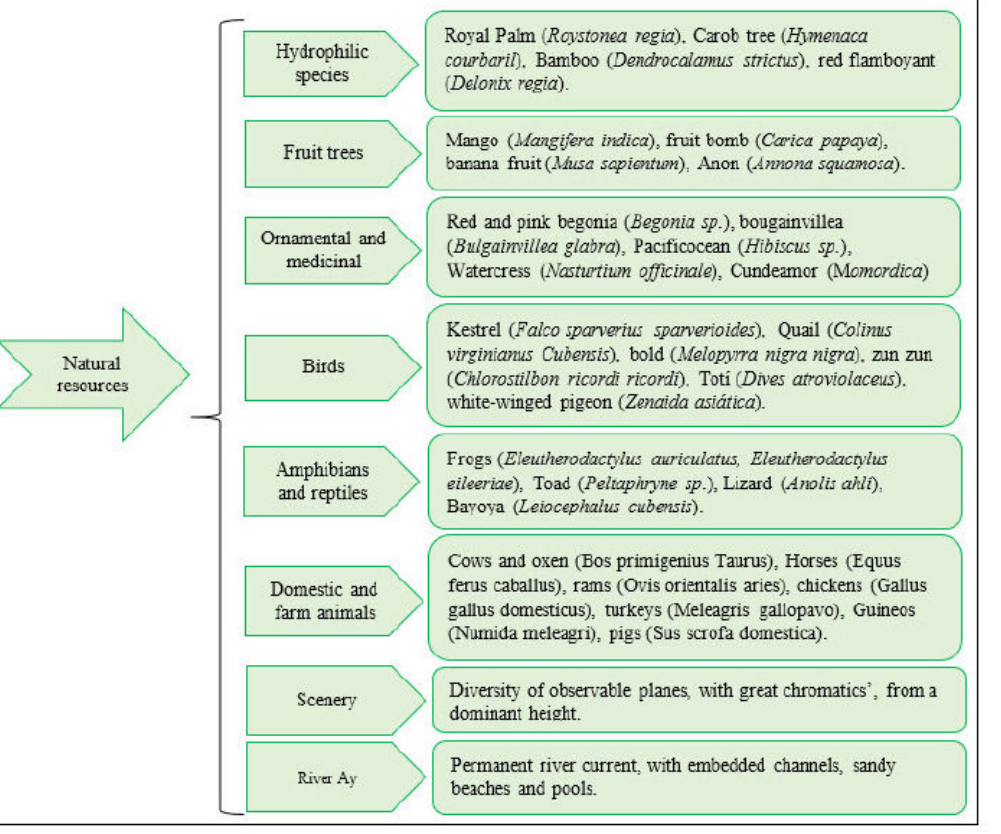
Figure 3. Inventory of natural resources available for agrotourism. Source: own elaboration based on the results of the inventory of resources in Hacienda